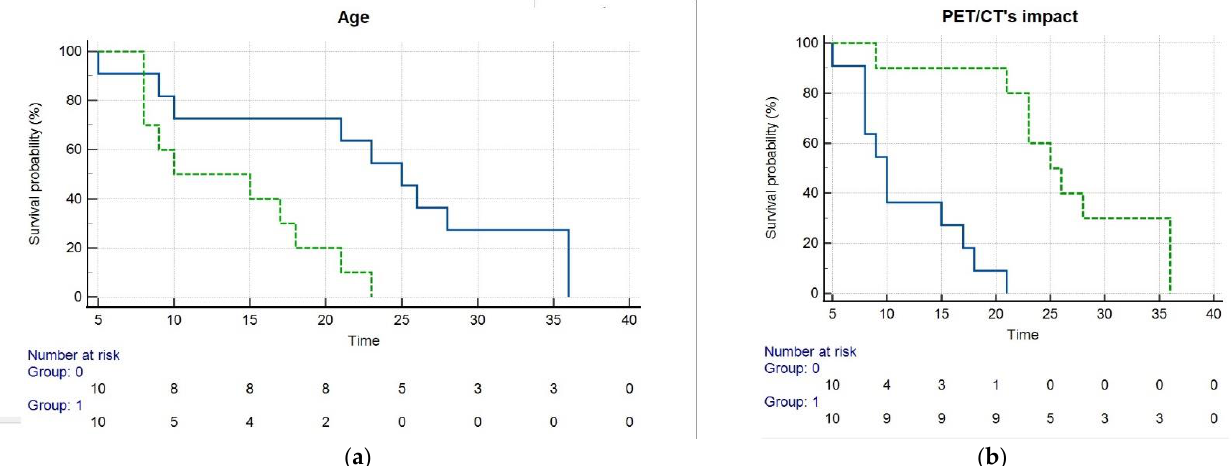
Figure 5. Kaplan–Meier analysis depicts overall survival (months) after 90 Y-TARE as a function of patient age ( a ) and post-TARE PET/CT’s impact on clinical management ( b ). Panel a shows that patients with age ≤ 69 years (blue line, group 0) had significantly ( p = 0.005) longer OS than those aged > 69 years (green line, group 1). Panel b demonstrates that patients whose clinical management was influenced by PET/CT (green line, group 1) had meaningfully ( p < 0.001) longer OS than those in which PET/CT‘s impact was scored as non -relevant (blue line, group 0).